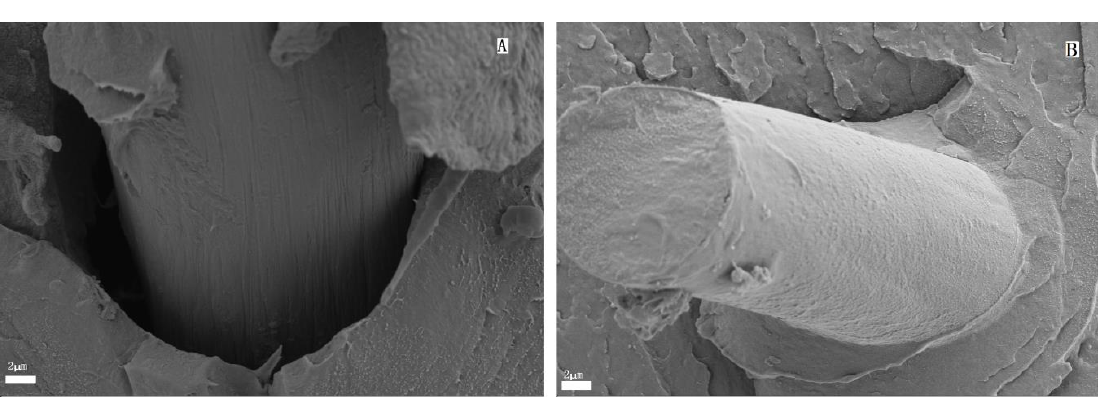
12 of 16 Figure 12. Activation energy as a function of relative crystallinity for pure PET, PET/CF, and PET/PMMA-g-CF composites using the FWO method. 3.4. Morphology of the Composites